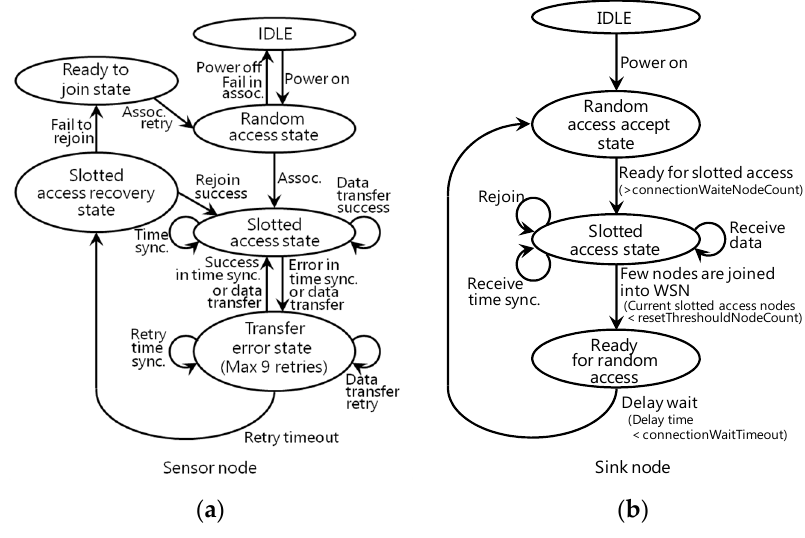
Figure 5. State diagram: ( a ) sensor node; ( b ) sink node.